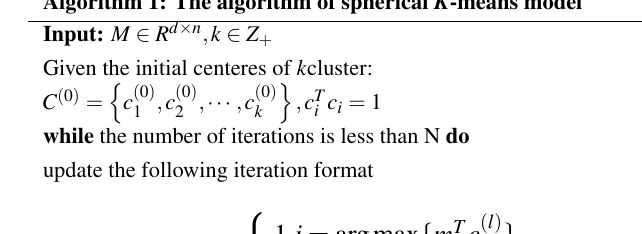
Algorithm 1: The algorithm of spherical K -means model